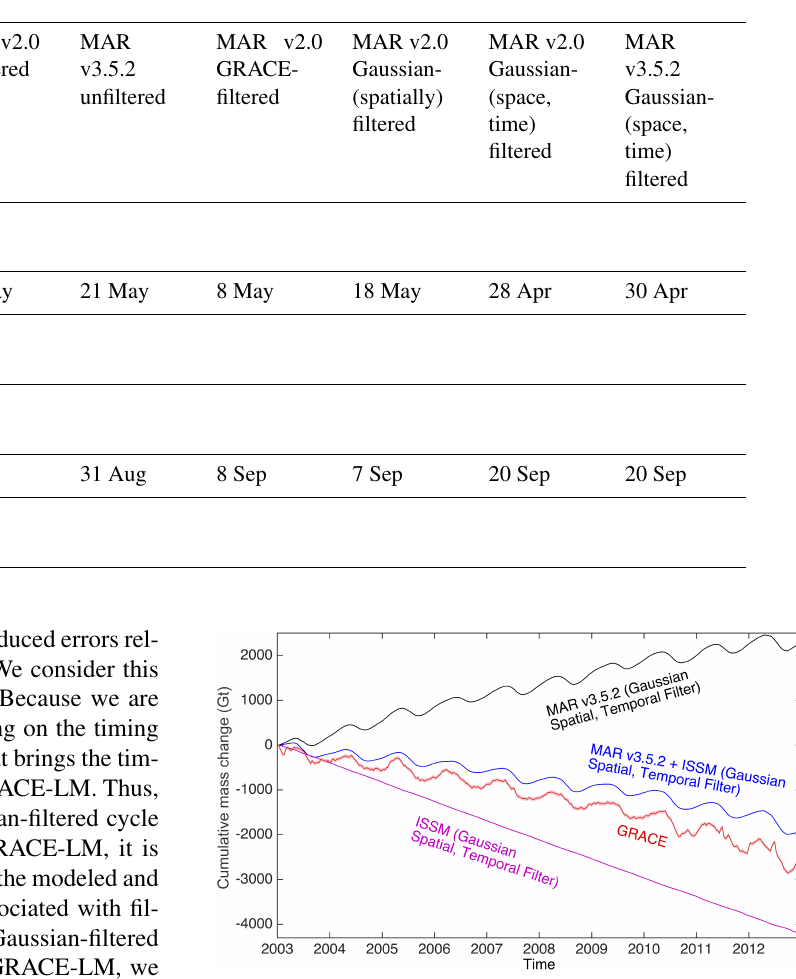
Table 1. Timing of maximum and minimum peaks in the seasonal cycle of GrIS-wide detrended cumulative mass change for GRACE-LM and MAR for the January 2003–December 2010 period. For GRACE-LM, the median value and bounds for the 95% confidence interval of the distribution after accounting for uncertainty in GRACE-LM are listed. The uncertainty bounds have been extended by 10 days to account for potential errors associated with temporal resolution.